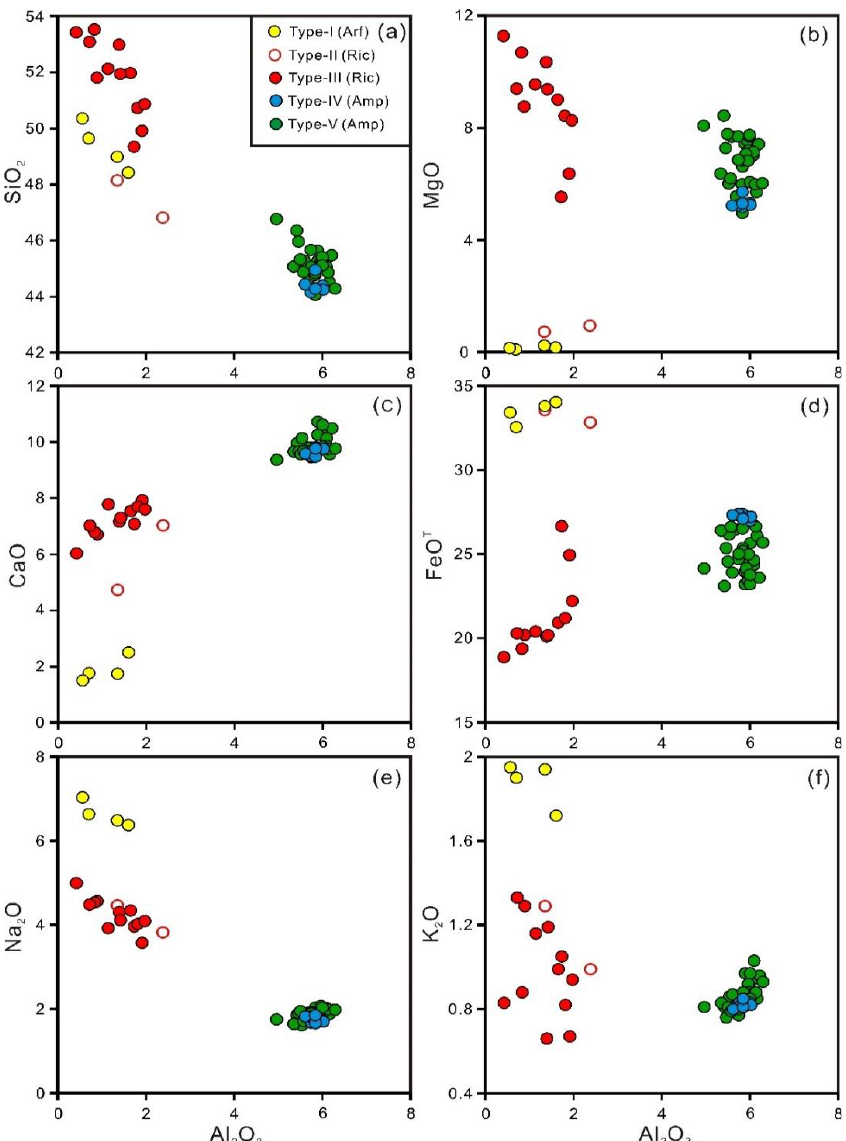
Figure 4. Diagrams of SiO 2 ( a ), MgO ( b ), CaO ( c ), FeO T ( d ), Na 2 O ( e ), and K 2 O ( f ) vs. Al 2 O 3 of amphibole in the Huangyangshan deposit in wt%.